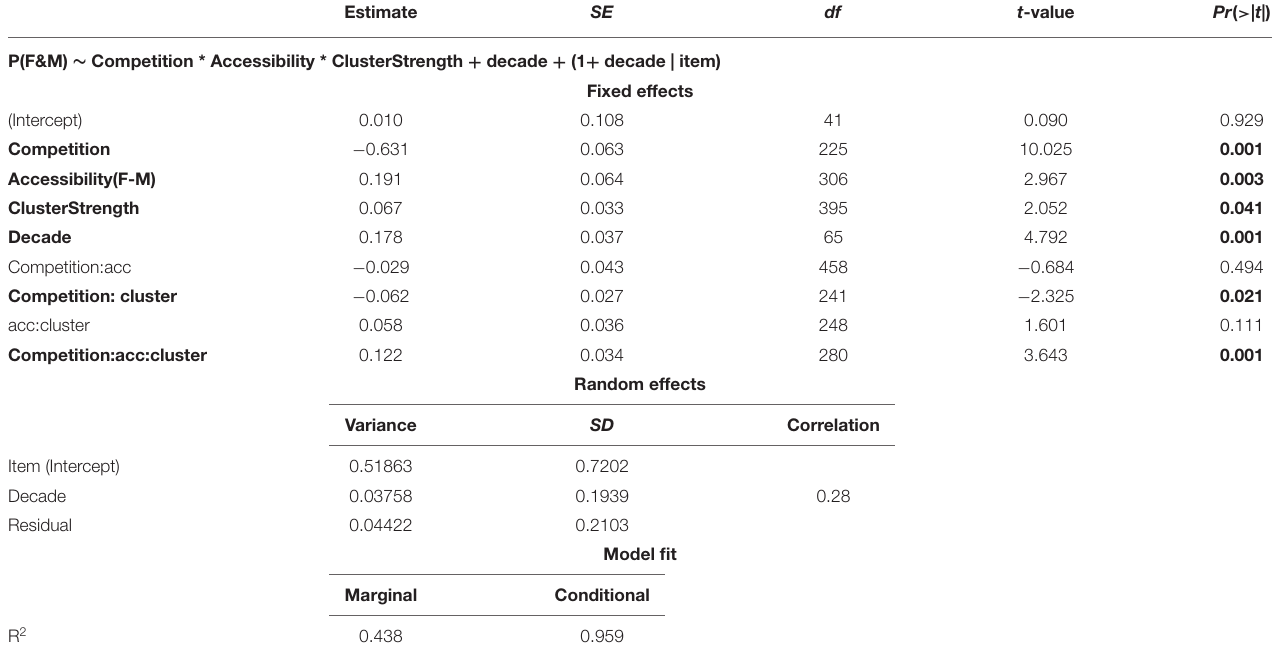
TABLE 1 | Results of fixed effects in the linear mixed model, predicting the P(F&M) order from the relative accessibility of female and male terms, the log-frequency of M&F order, and the cluster strength of related cases as weighted by semantic and morphological similarity. Estimate SE df t